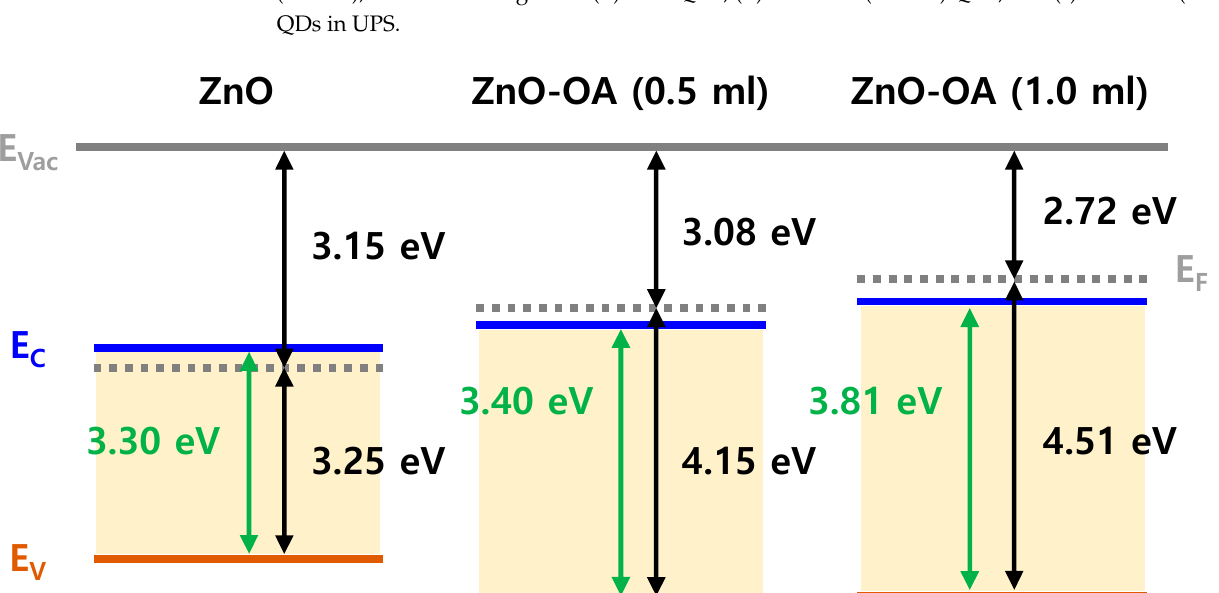
Figure 9. Electron energy level diagram of ZnO QDs, ZnO-OA (0.5 mL) QDs, and ZnO-OA (1.0 mL) QDs.